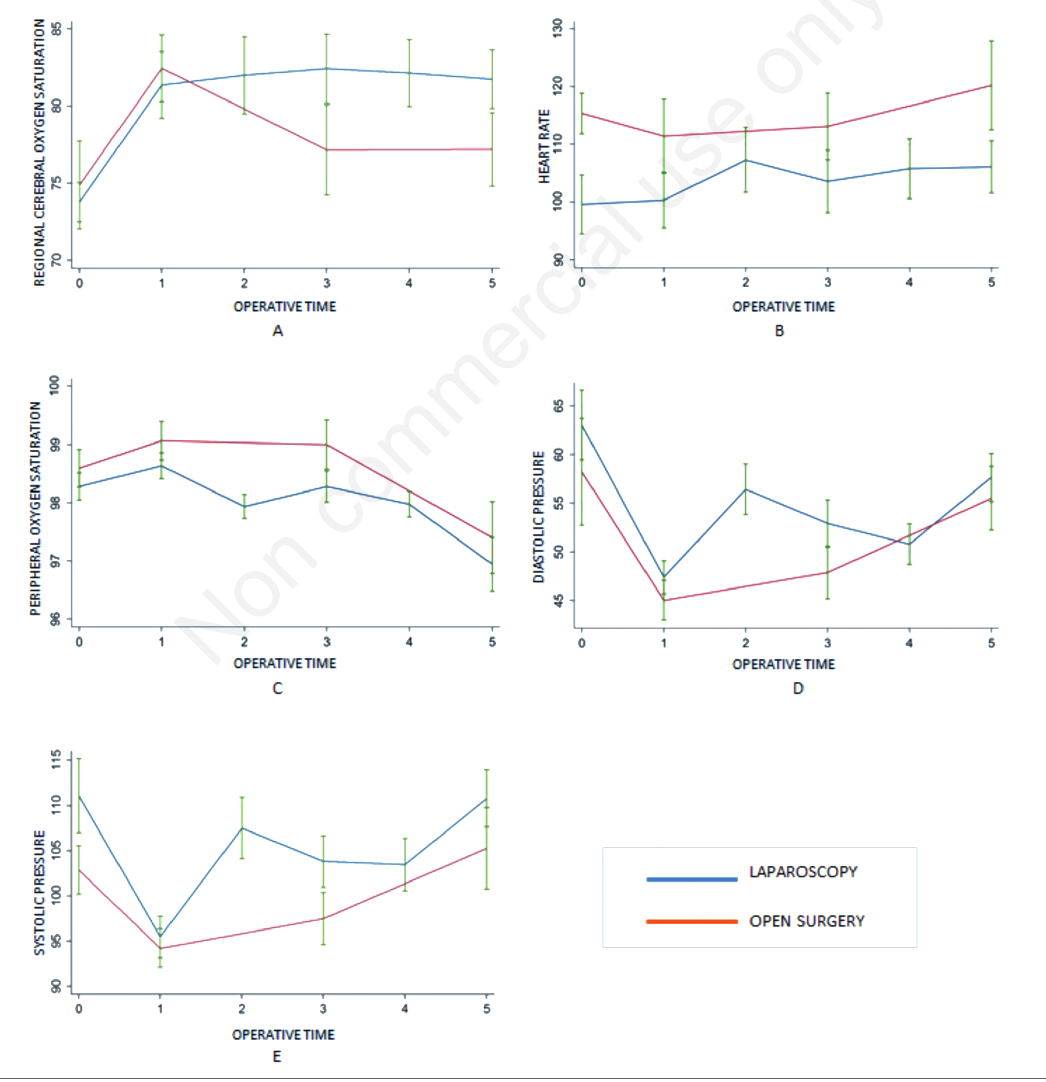
Figure 1. Profile of regional cerebral oxygen saturation (A), heart rate (B), peripheral oxygen saturation (C), diastolic pressure (D) and systolic pressure (E) in LAP and OPEN groups at the different surgical time